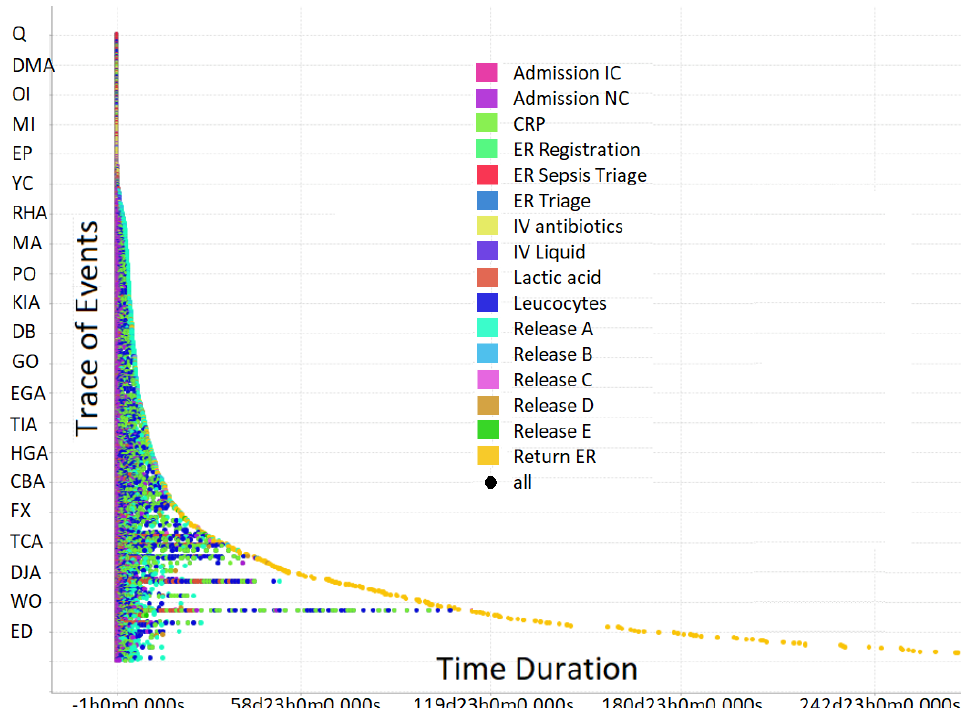
Figure 6. Privacy assurance evaluation at intra-organizational level (Sepsis event log using the Dotted Chart algorithm from the ProM